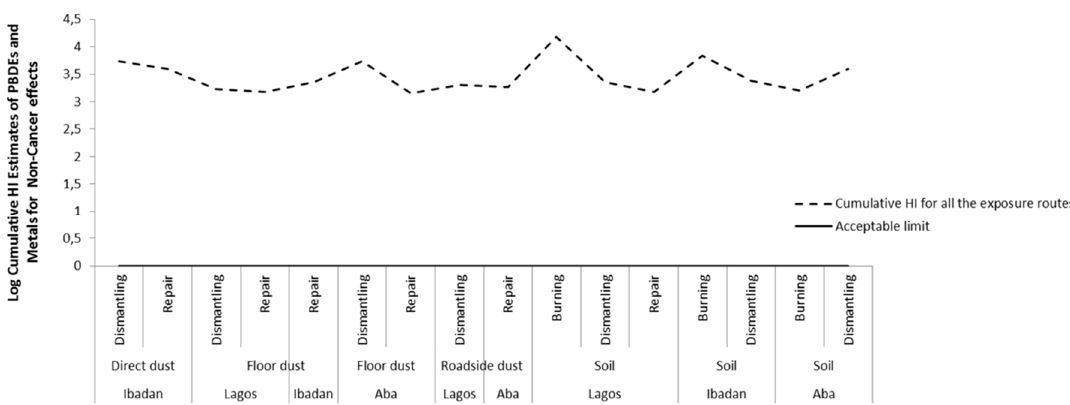
Figure 4. Total Hazard index (HI) for non-cancer risk via each exposure route of metal and Polybrominated Diphenyl Ethers (PBDEs) in soil and dust at various e -waste sites in the three locations.